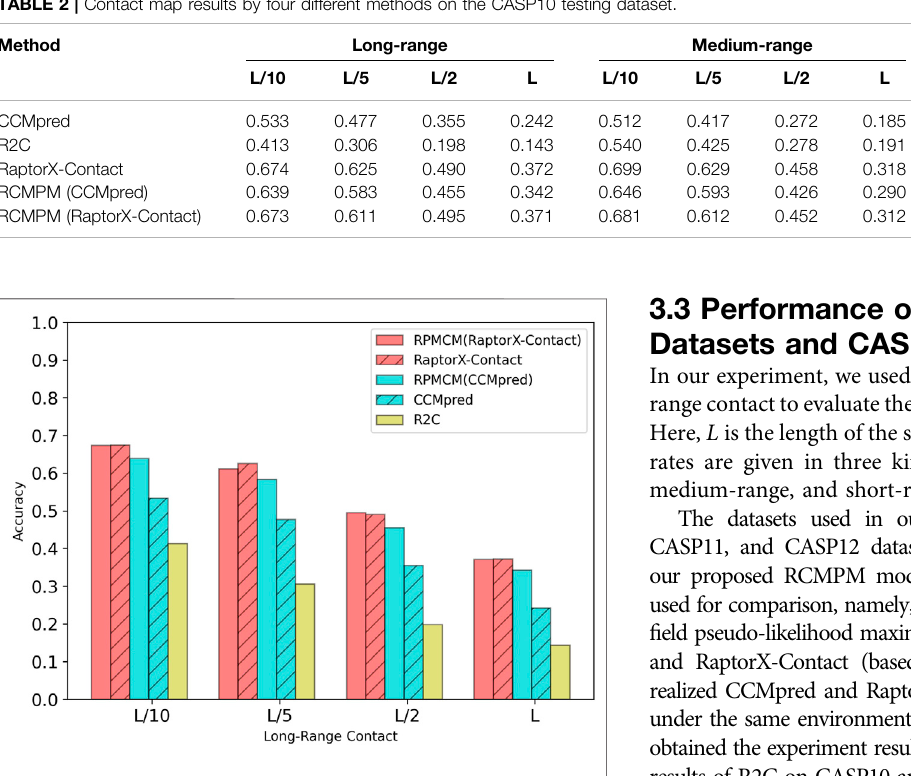
FIGURE 4| Comparison of method accuracy for the long-range contact on the CASP10 testing